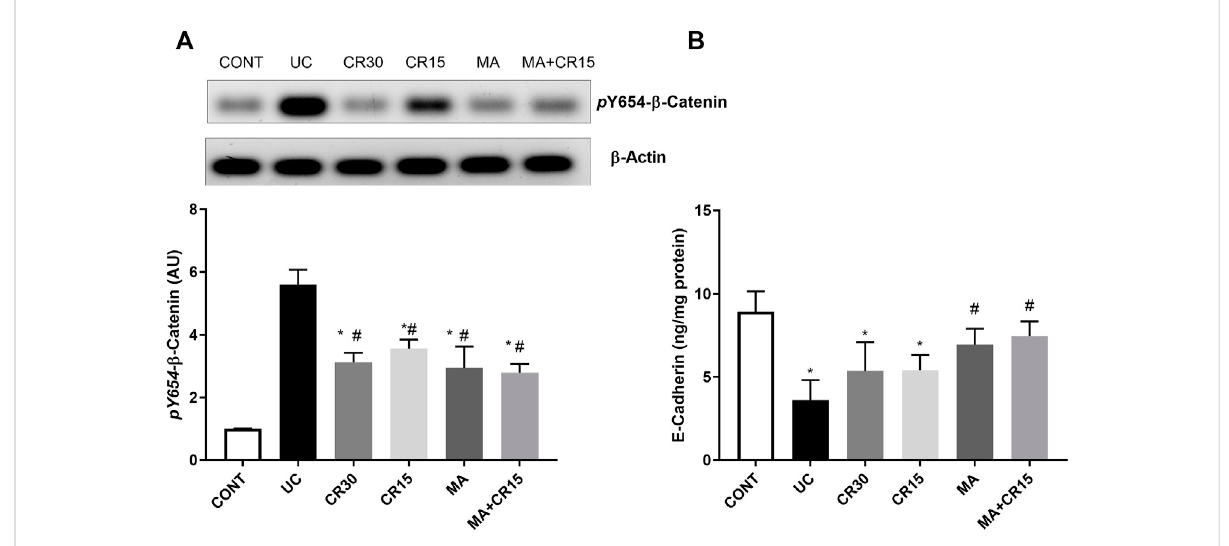
FIGURE 11 Effect of mirabegron and/or carvedilol on colon protein expression/content of (A) p (Y654) - β -cateninand (B) E-cadherin in rats with IAA-induced ulcerative colitis. Data are presented as mean ± SD(n = 4 – 6).Statisticalanalysiswas carried out usingone-wayANOVA followedbyTukey ’ s posthoc test; p < 0.05, as compared to the (*) CONT and (#) UC groups. CONT, control; CR, carvedilol; IAA, iodoacetamide; MA, mirabegron; UC, ulcerative